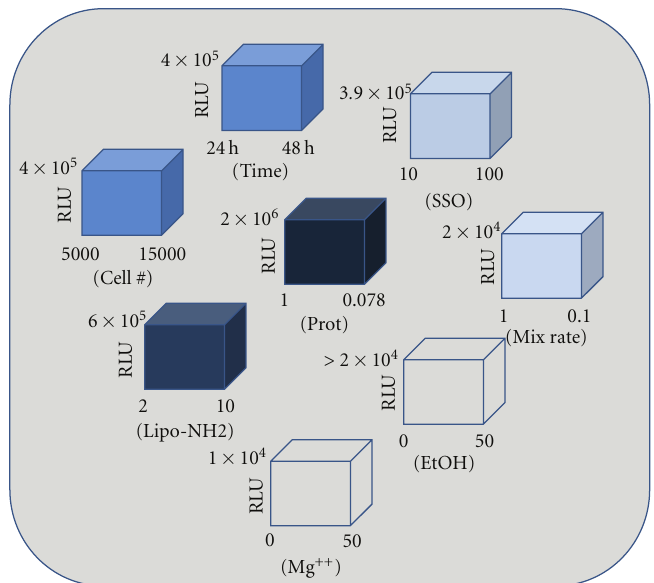
Figure 2: High-throughput screening experimental design analyzing parameters a ff ecting SSO bioactivity in the Hela pLuc-705 system. RLU: relative luminescence, Lipo-NH2: lipofectamine, Prot: protamine concentration, ETOH: ethanol concentration, Mg ++ : magnesium concentration.